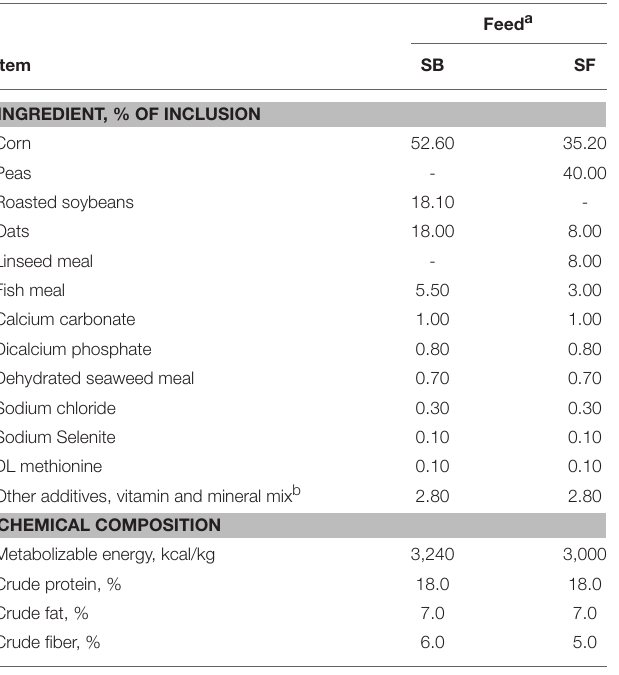
TABLE 1 | Composition and nutrient contents of the feeds offered to pasture-raised broilers.